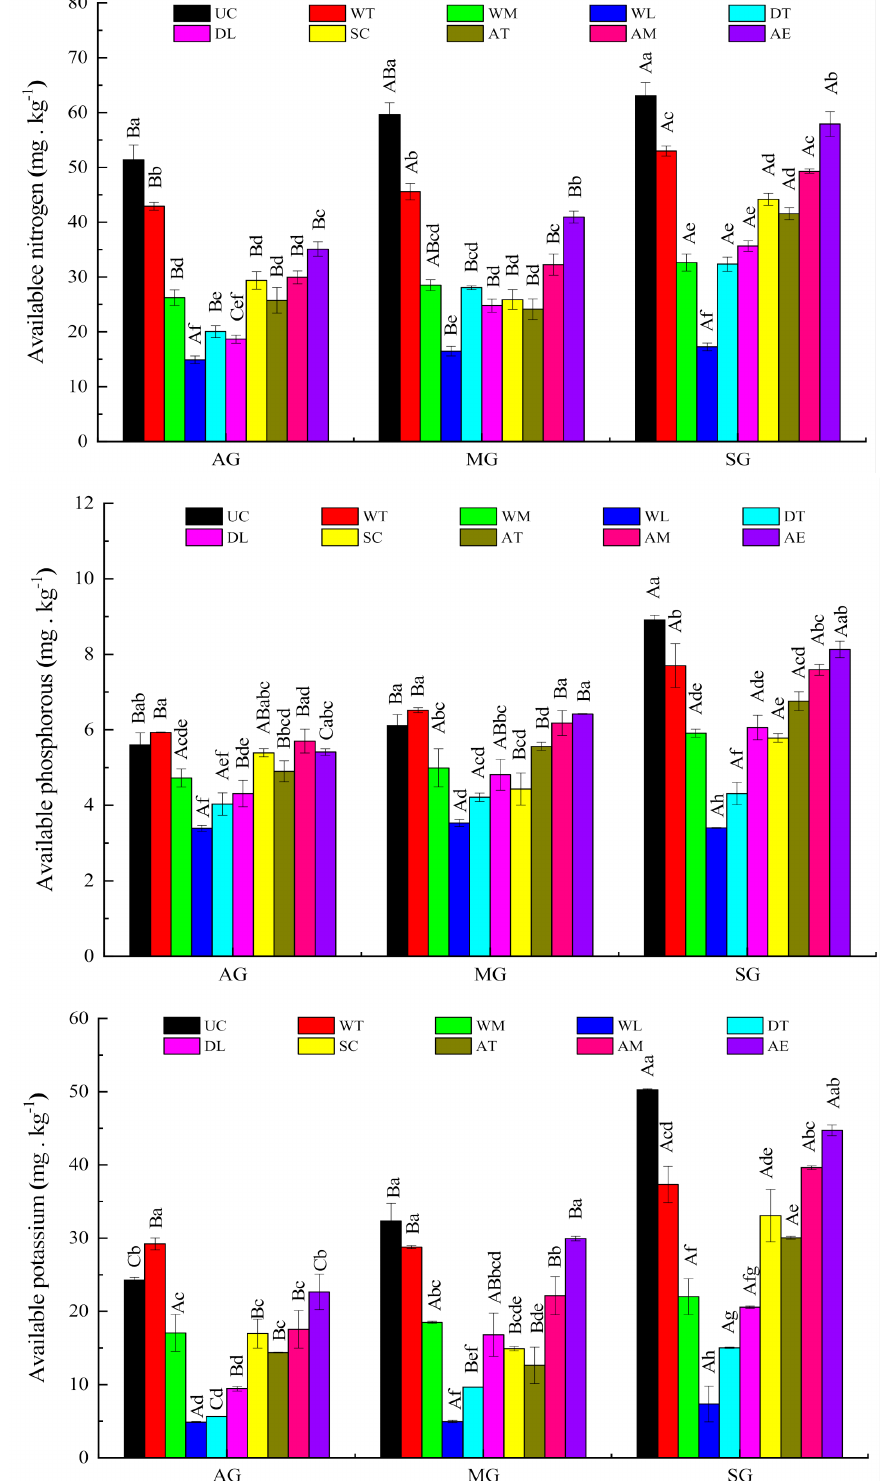
Figure 10. The available nitrogen, available phosphorus and available potassium in the different spatial positions in different stages of Benggang